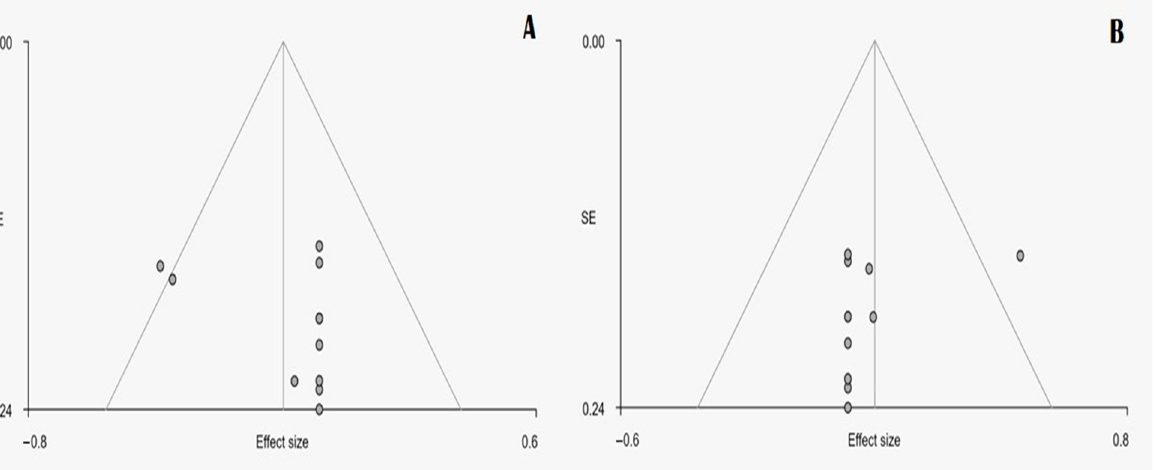
Figure 3. Funnel plot diagrams on all the areas that showed statistically significant differences between JME patients and controls. ( A ) Thalamus, ( B ) Left median cingulate cortex, ( C ) Left precentral gyrus, ( D ) Left supplementary motor area, ( E ) Right Insula, ( F ) Right superior frontal gyrus.